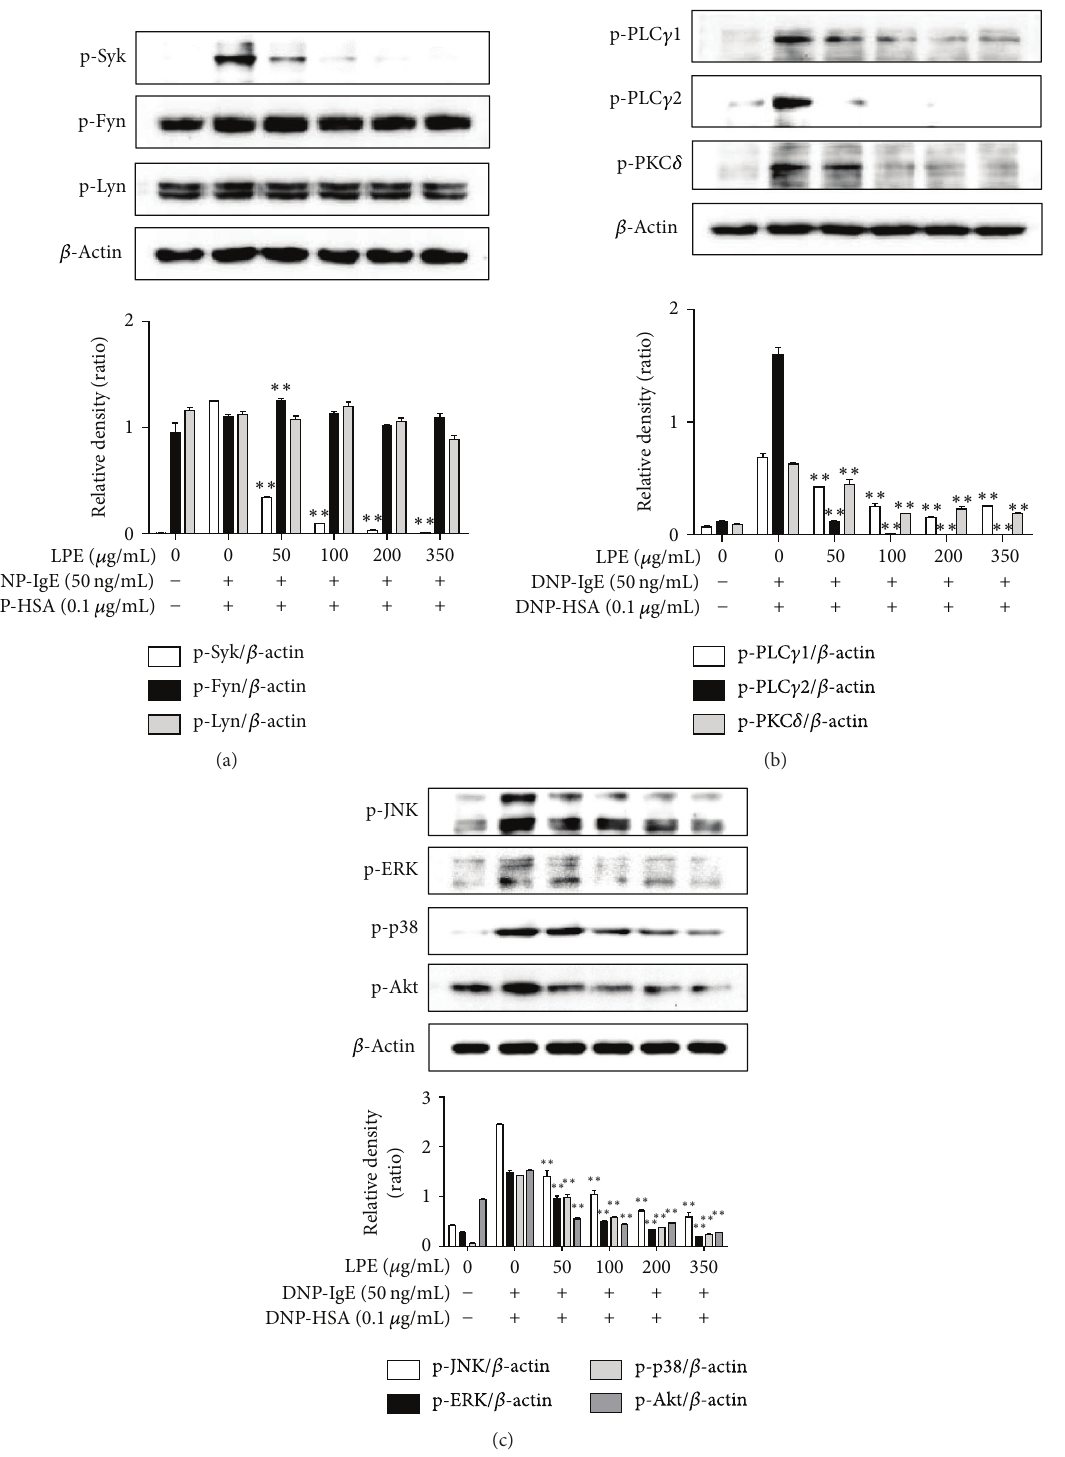
Figure 5: Effect of LPE on phosphorylation of rate-limiting or intermediate proteins in the Fc 𝜀 RI signaling cascade. IgE-sensitized RBL-2H3 cells were preincubated with LPE for 1h and then stimulated with antigen for 10min. The above cells were washed with 1x DPBS and lysed with cell lysis buffer. The expression of p-Lyn, p-Fyn, p-Syk, p-ERK, p-JNK, p-p38, p-Akt, p-PLC 𝛾 1, p-PLC 𝛾 2, p-PKC 𝛿 , or 𝛽 -actin was determined as described in Section 2. Similar results were obtained in three independent experiments. ∗∗ 𝑃 < 0.01 versus DNP-HSA-treated group. (a) p-Syk, p-Fyn, and p-Lyn; (b) p-PLC 𝛾 1/2 and p-PKC 𝛿 ; (c) p-JNK, p-ERK, p-p38, and